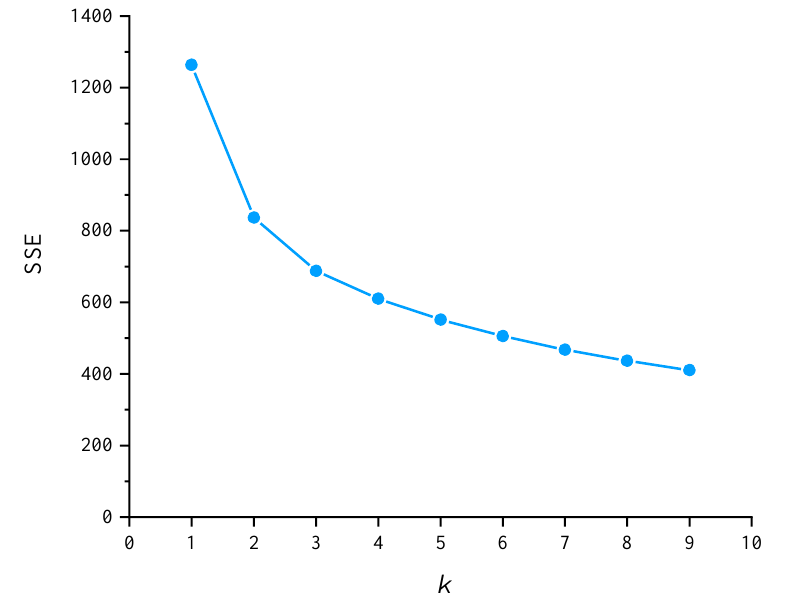
Figure 6. Variation in the SSE value with k .